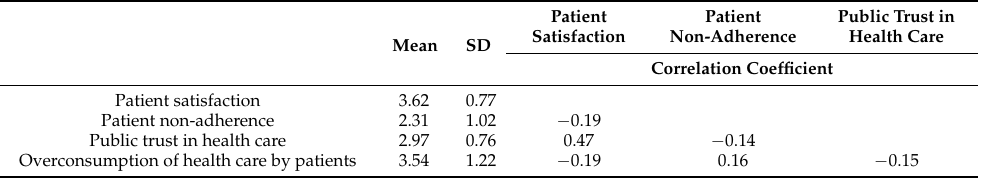
Table 4. Descriptive statistics (mean, standard deviation, and correlation